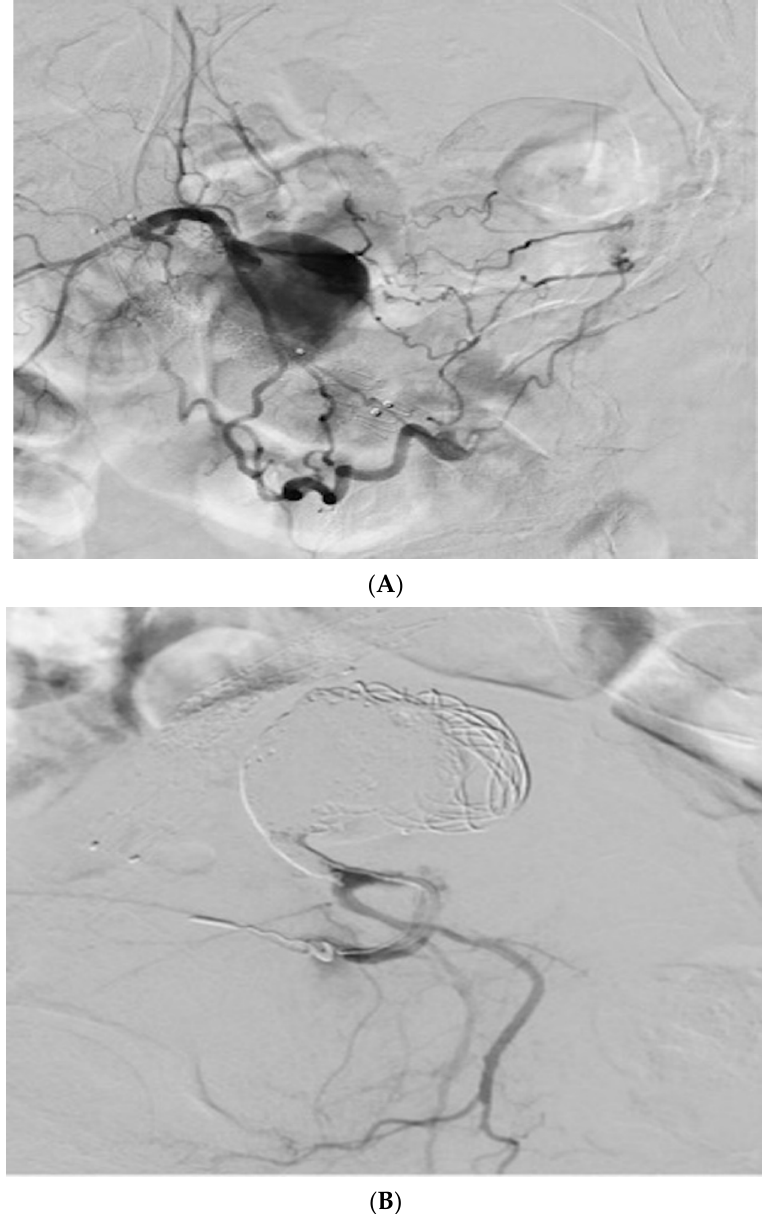
Figure 3. ( A ). Initial angiogram demonstrated a large PSA arising from the left internal iliac artery. ( B ). Post-coil embolization angiogram demonstrated non-opacification of the